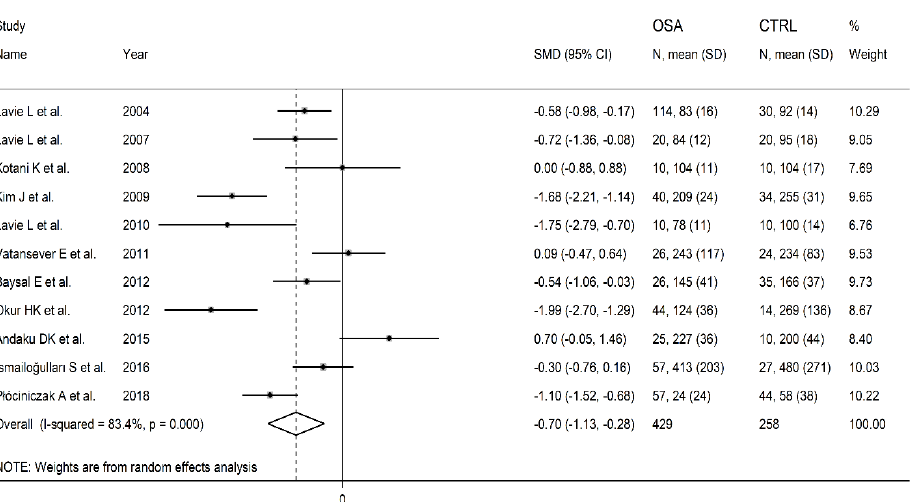
Table 2. The Joanna Briggs Institute critical appraisal checklist.